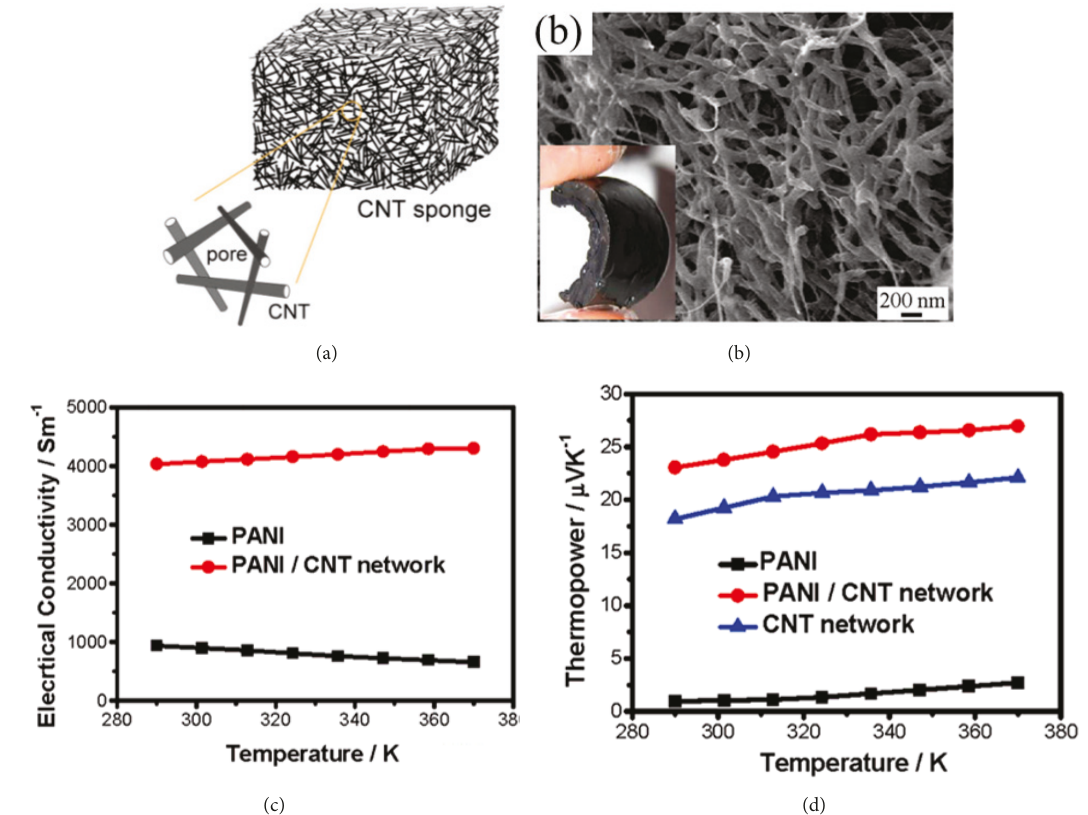
Figure 13: (a) Schematic of the CNT sponge [209] (b) SEM image of the CNT-PANI composite. The inset shows its macrophoto. ((c) and (d)) Electrical conductivity and thermopower of pure PANI, CNT-PANI composite, and pure CNT network as a function of temperature [210]. All panels are reproduced with permission [209, 210].